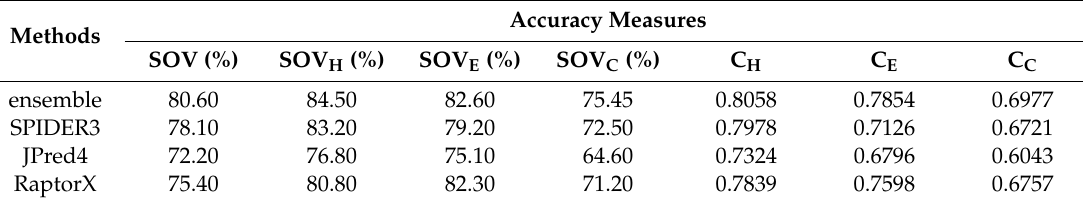
Figure 5. 𝑄 (cid:2871) accuracy of ensemble model and other three methods for 203 proteins from Critical Appraisals Skills Programme (CASP203). Appraisals Skills Programme (CASP203). Table 4. SOV scores and MCC results by four di ff erent methods for 203 proteins from Critical Appraisals Table 4. SOV scores and MCC results by four different methods for 203 proteins from Critical Appraisals Skills Programme (CASP203). Skills Programme